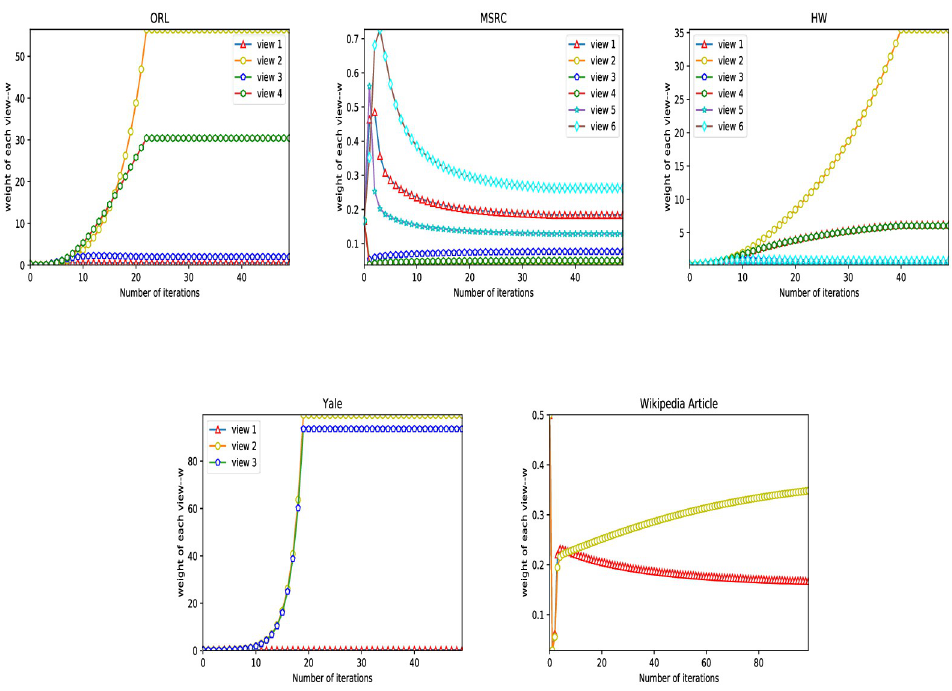
Fig 7. The change of the weight w of each view on the five datasets in the RMVCP-1 process.